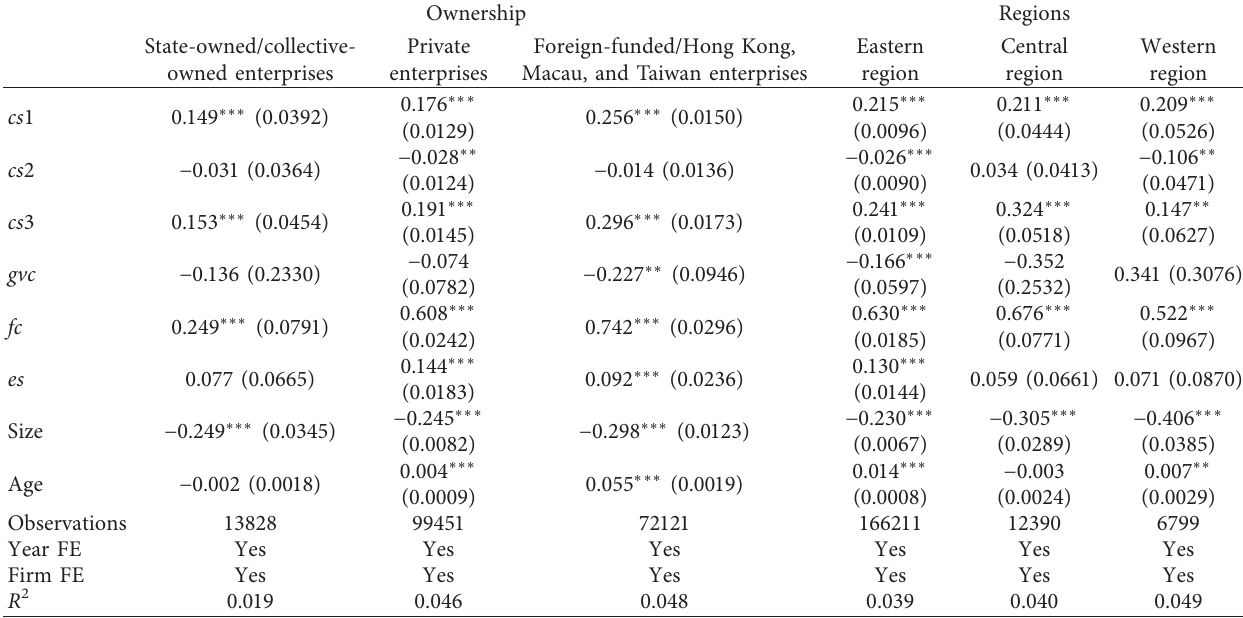
Table 6: The estimated results of regressions on subsamples classified by ownership and regions.